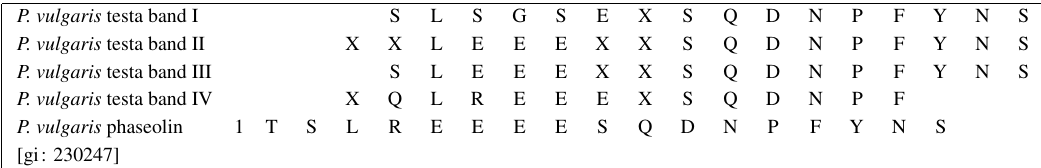
Fig. 2 – SDS polycarylamide gel electrophoresis and Western blotting of proteins from Phaseolus vulgaris seeds. (A) Coomassie blue staining (pro- tein) and (B) Western blotting employing an antiserum against phaseolin. (1) purified phaseolin from embryo; (2) total extracted proteins from embryo; (3) total extracted protein from testa; (M) molecular markers, kDa × 10 3 .